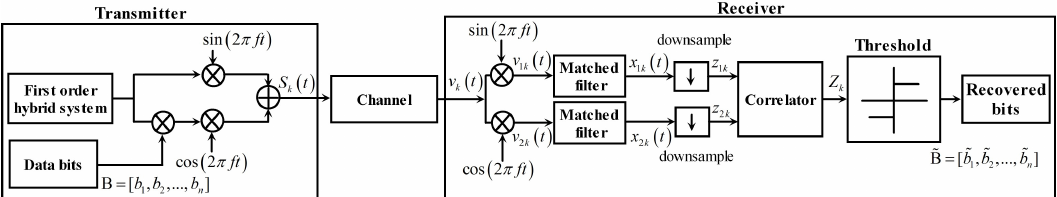
Figure 4. Block diagram of the proposed